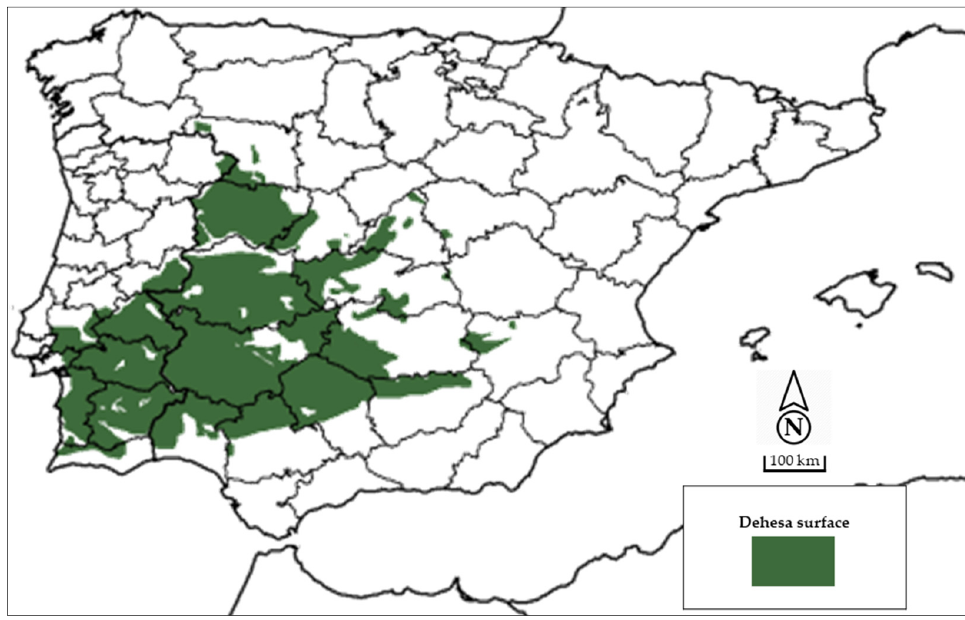
Figure 1. Distribution of dehesa in the Iberian Peninsula. Source: [55,56]. Authors own elaboration.